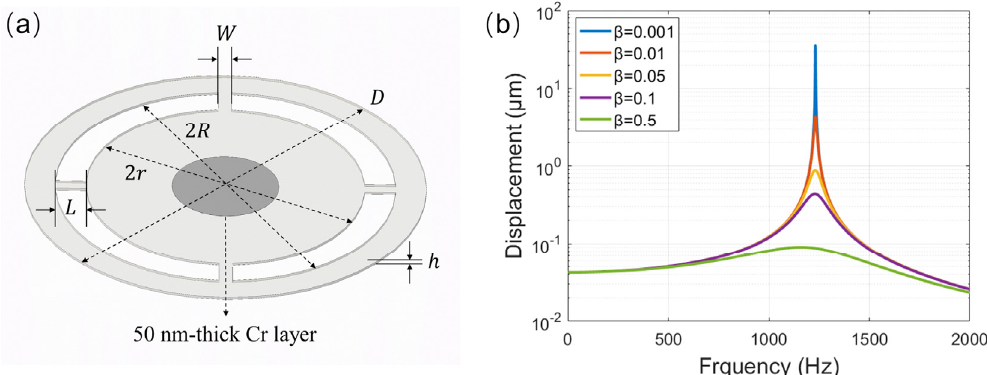
Figure 1. ( a ) Schematic diagram of the wheel-shaped glass diaphragm; ( b ) the calculated frequency responses of the wheel-shaped glass diaphragm with W = 2.0 and L = 2.3 mm at different damping coefficients.